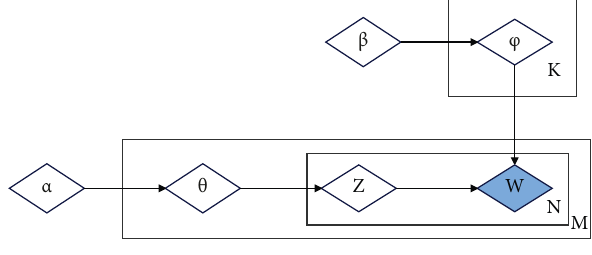
Figure 1: LDA model